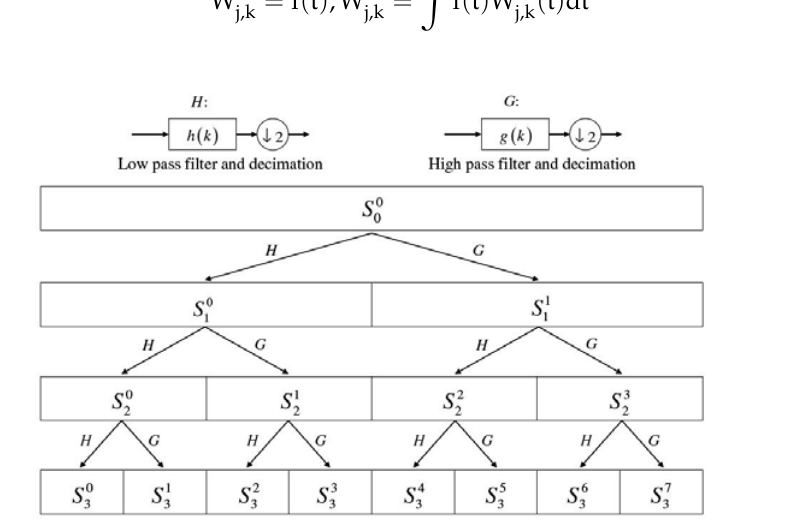
Figure 2. Tree structures of wavelet packet transform [30].